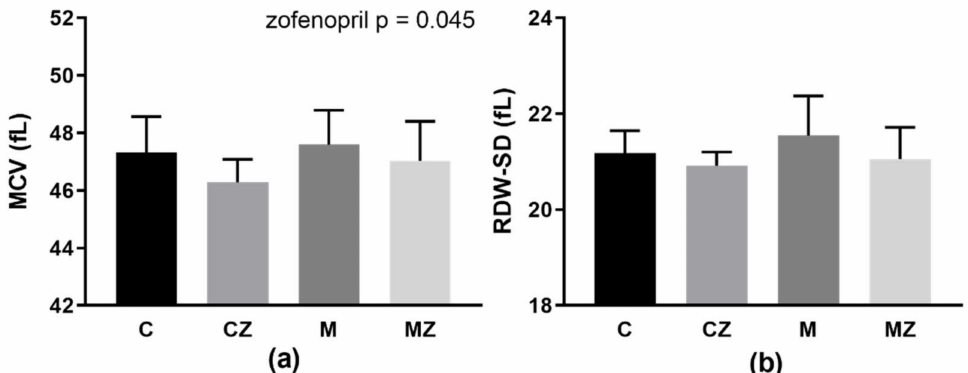
Figure 3. Basic erythrocyte characteristics in experimental groups: MCV ( a ), RDW-SD ( b ). Abbreviations: MCV—mean cell volume, RDW-SD—red cell distribution width, C—control group, CZ—zofenopril-treated group, M—MLN-treated (MLN- 4760, ACE2 inhibitor) group, MZ—zofenopril and MLN-treated group. Data are presented as mean ± standard deviations.